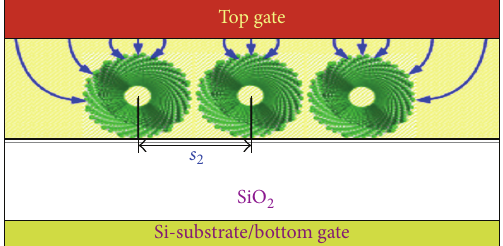
Figure 12: Cross-sectional view of a multitube CNFET.